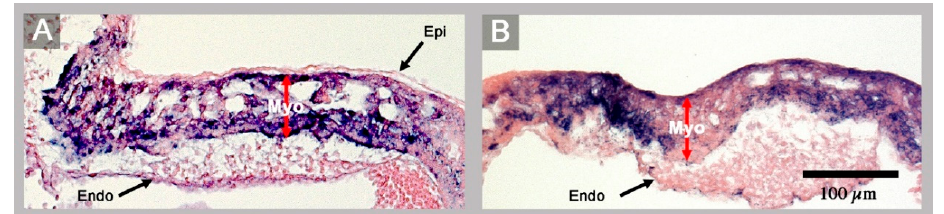
Figure 2. Starting at the level of the confluence of the systemic veins (sinus venosus), this sequence of transverse histological sections depicts the Pitx2 expression pattern and the veno-atrial connections of the abnormal HH-stage 23 heart with left cardiac isomerism. Pitx2 is expressed in the entire wall of the heart (blue staining). The sinus venosus (endothelial lining marked in light blue) drains to a narrow midline canal ( A , B ) that belongs to the atrial inflow component (endothelial linings marked in green). The atrial inflow component is connected to both atria (endothelial linings marked in magenta) and incompletely divided into left and right portions by a rudimentary interatrial septum (red arrowhead marks the crest of the septum) ( E , F ). The atrial inflow component is demarcated from the rest of the atria by two myocardial folds (marked by blue asterisks). Note that the common pulmonary vein (endothelial linings marked in orange) is connected to the right portion of the atrial inflow component ( C , D ). Abbreviations: E = esophagus; LP = left lung bud; TB = tracheal bifurcation; RP = right lung bud; SV = sinus venosus; other abbreviations as used before.